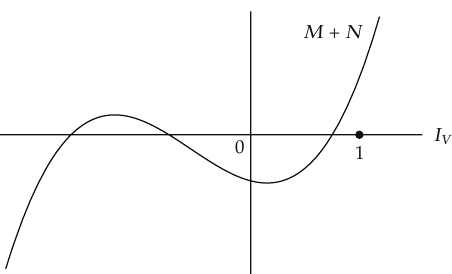
Figure 5: Graph of the polynomial M (cid:7) N